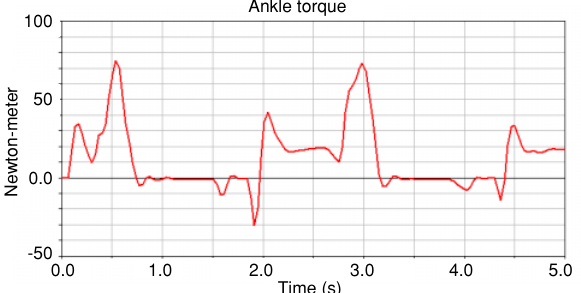
Figure 13 Dorsiflexion/plantarflexion torque.